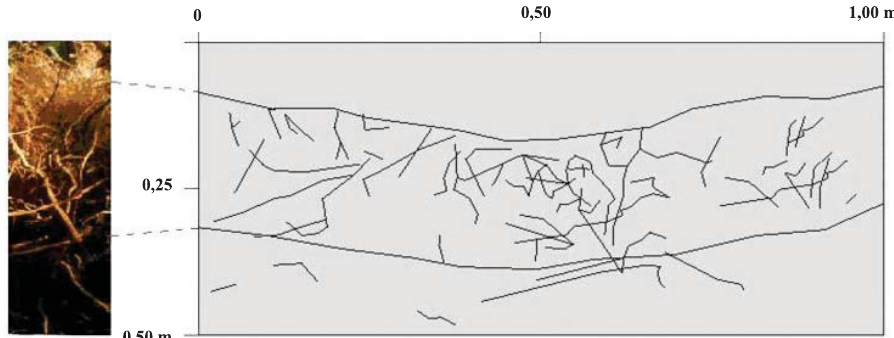
Figura 1. Perfil pedológico do solo sob floresta da Gleba Pinguim-ribeirão Floriano. Adaptado de Alves (2007).